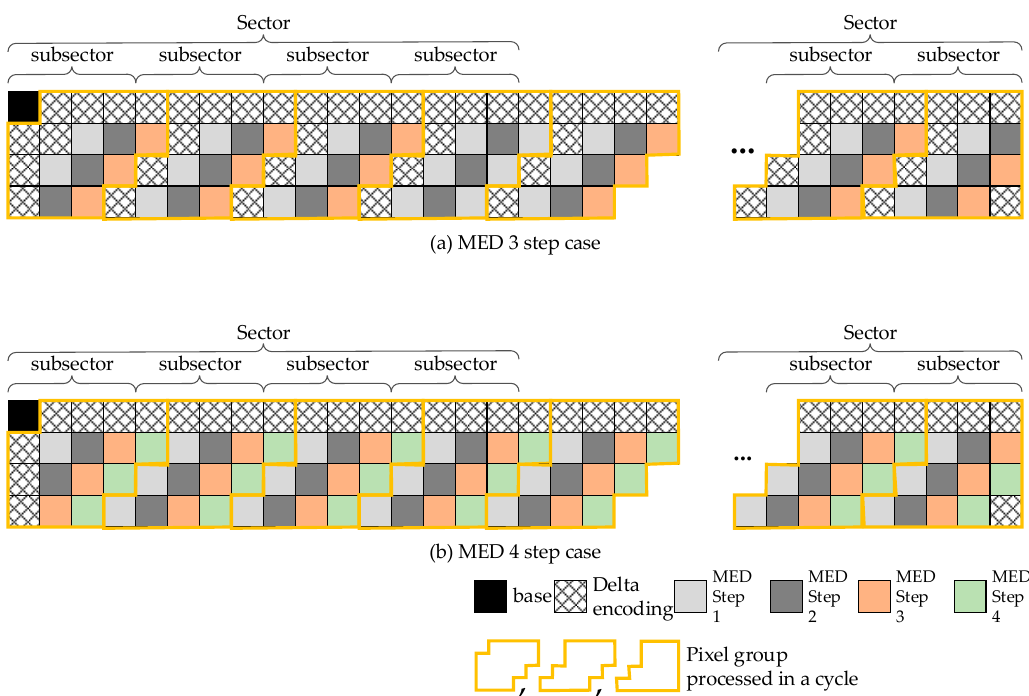
Figure 4. MED prediction sequence for three-step and four-step cases. ( a ) Three step prediction implementation uses delta modulation at the boundary of blocks; ( b ) Four step prediction implementation removes some delta modulations by referring the neighborhood block’s pixels.